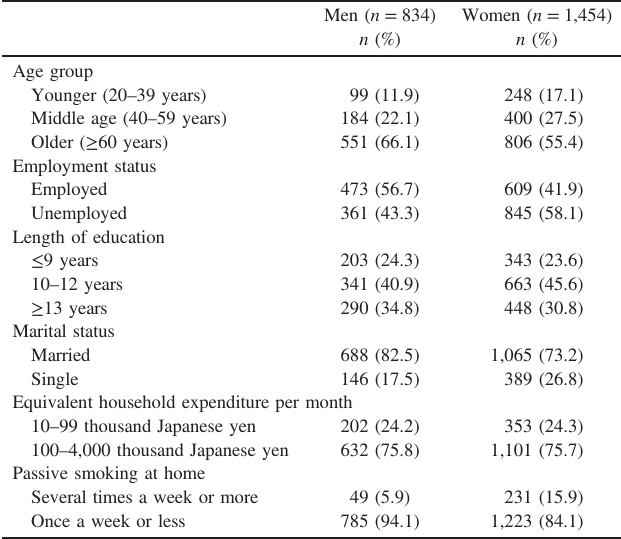
Table 1. Characteristics of participants by gender among non- smokers in NIPPON DATA2010 ( n = 2,288)